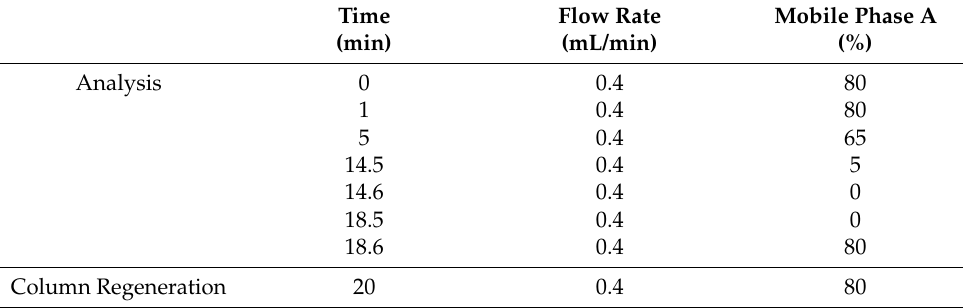
Table 9. LC-gradient conditions for center